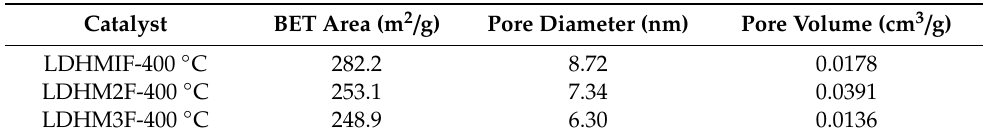
Table 1. Textural properties of activated Mg / Fe layered double hydroxides.